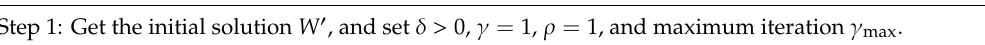
Algorithm 2. The procedure of the local search in VNS.